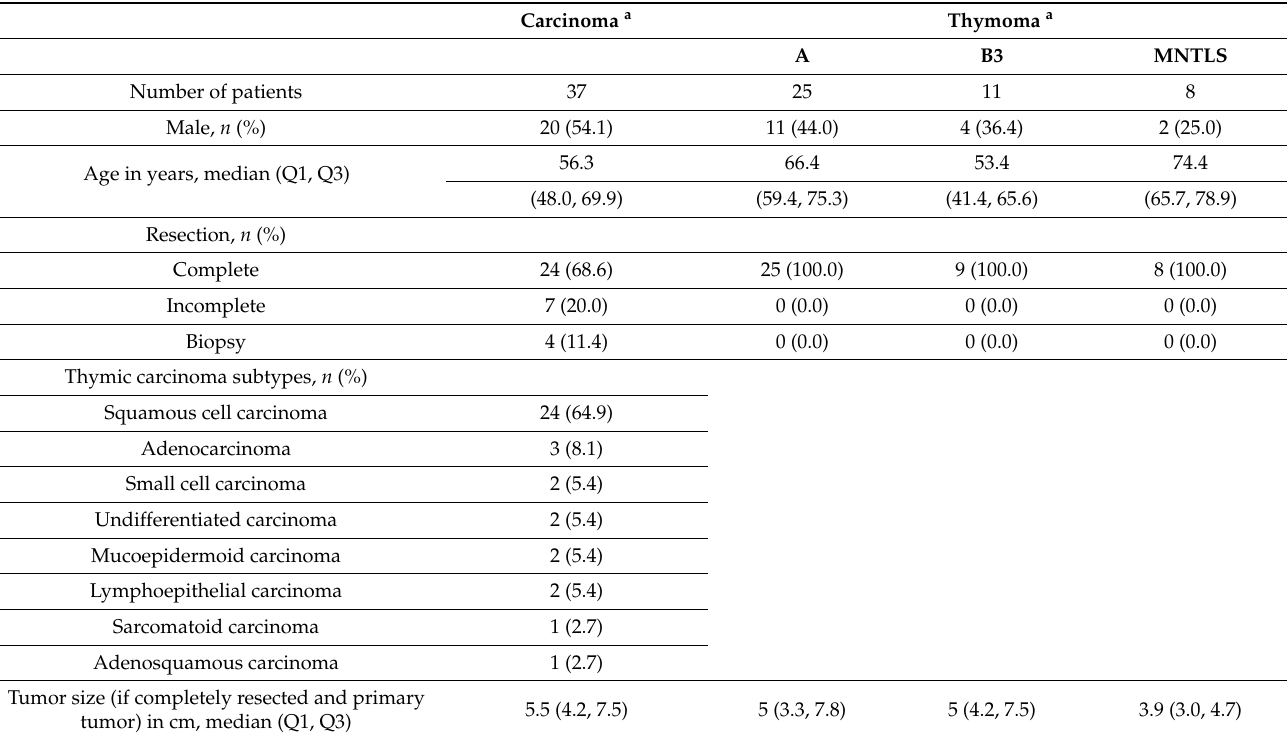
Table 1. Demographics, treatment, thymic epithelial tumor subtypes, staging, and outcome of the study population ( n =